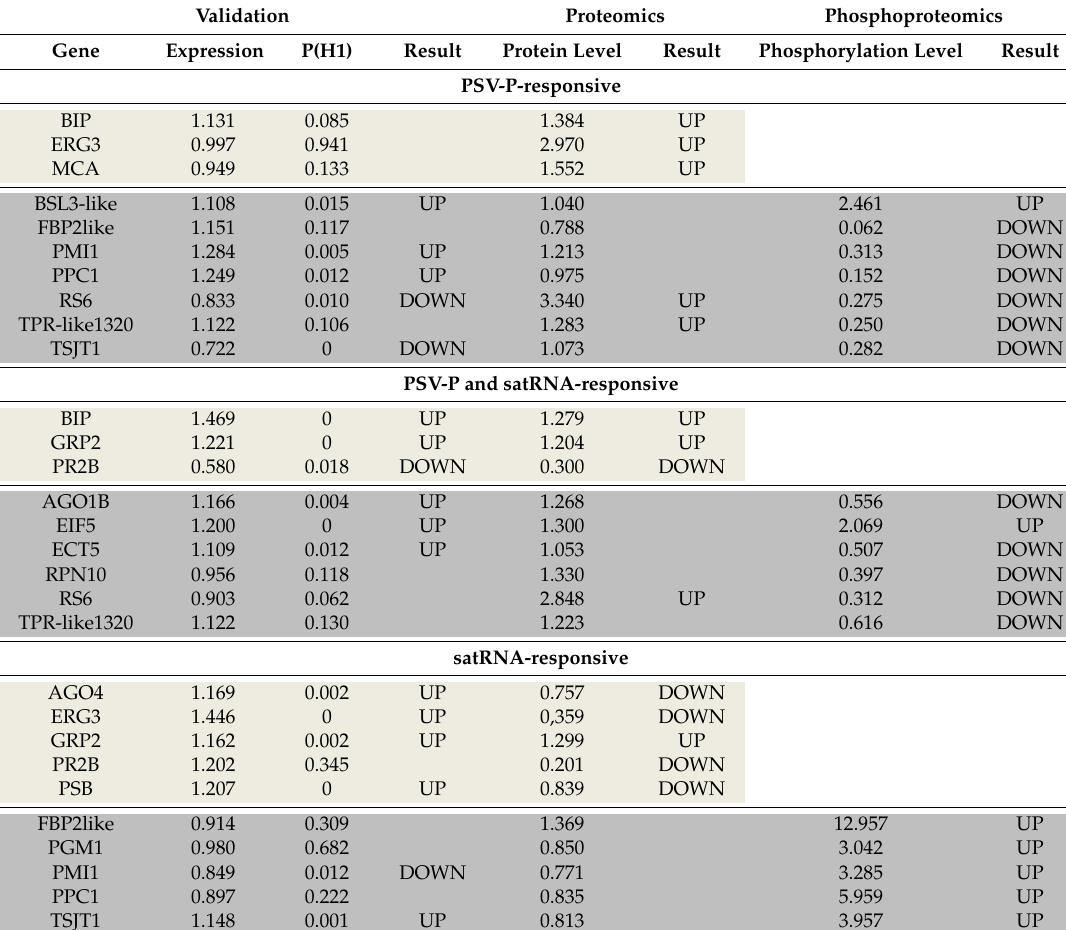
Table 2. Validation of the proteomic (light grey) and phosphoproteomic (grey) data by gene expression levels analysis (quantitative reverse transcriptase real-time polymerase chain